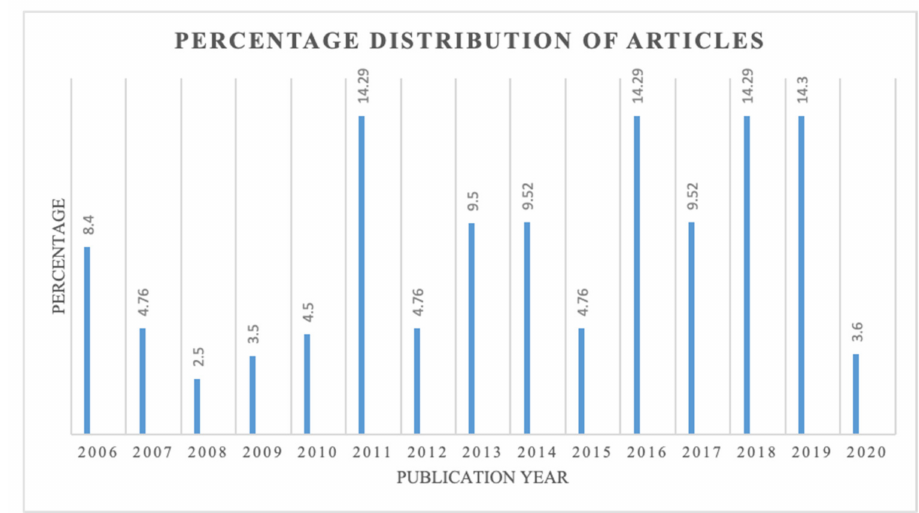
Figure 2. Percentage distribution of articles during 2006–2020.